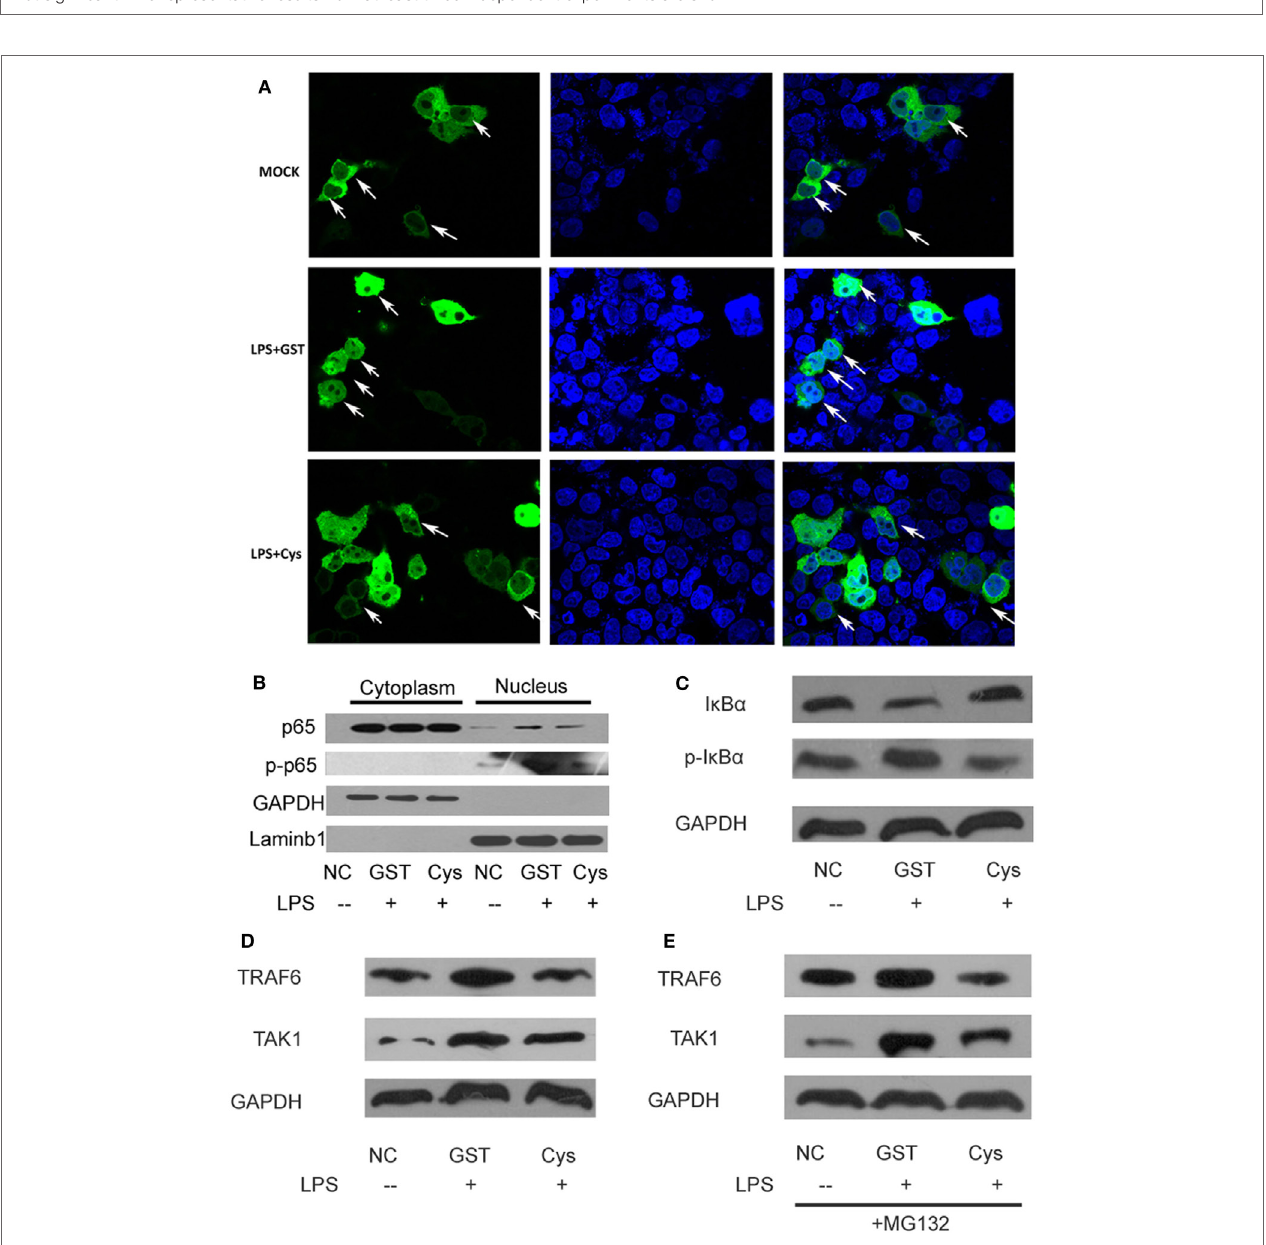
FigUre 3 | DsCystatin inhibits TLR2 and TLR4-directed NF κ B activation. (a,B) DsCystatin inhibits Borrelia burgdorferi -induced NF κ B activation in TLR2-293 cells (a) and LPS-induced NF κ B activation in TLR4-293 cells (B) , as determined by NF κ B Luciferase reporter assay. Cells that were not stimulated with LPS or B. burgdorferi were served as negative controls (NC) . Results are expressed as mean + SEM of three triplicate samples. * p < 0.05 and ** p < 0.01 ( t -test). The representative results from at least three independent experiments are shown. (c) A brief diagram of LPS or B. burgdorferi -induced TLRs signal pathway. (D) DsCystatin inhibits TLR4 signaling pathway at the TRAF6 level. NF κ B luciferase reporter was activated by overexpression of distinct signal molecules (MyD88, TRAF6, NEMO, IKK α , and NF κ Bp65) in TLR4-293 cells. The inhibition of DsCystatin on these molecule-directed NF κ B activity was determined by Dual Luciferase reporter assay. (e) DsCystatin inhibits TRAF6 overexpression-induced NF κ B activity in a dose-dependent manner. (F,g) DsCystatin could not inhibit IKK α or NF